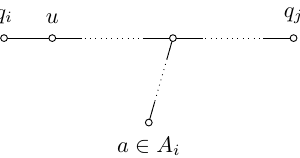
= q i . We need to check that the Figure 5. Illustration of the algorithm for checking Condition 3 when q (cid:54) path connecting q i and q j is outside G L ( S except for q i . For each leaf a from the representative set A i i ) of q i , we check that between G ( a , q i , q j ) is true. Left: between G ( a , q i , q j ) is true; right: between G ( a , q i , q j ) G L ( S is false, u ∈ i )